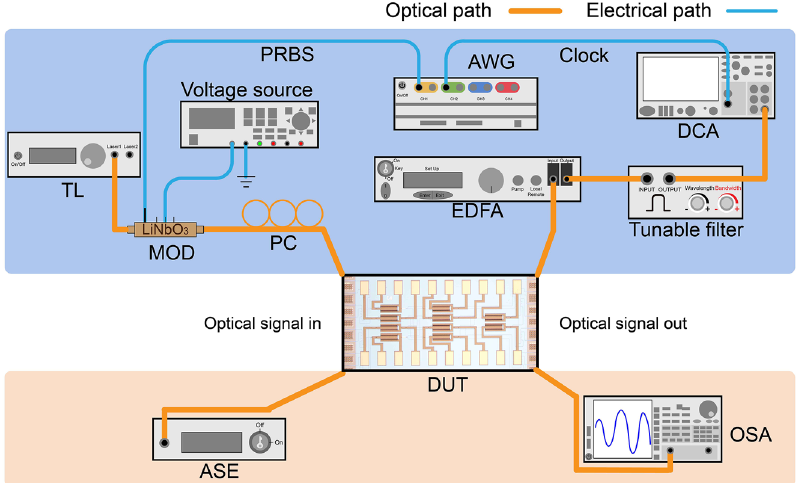
Figure 5: Experimental setup for characterizing the device (TL, tunable laser; ASE, amplified spontaneous emission; MOD, modulator; PC, polarization controller; AWG, arbitrary waveform generator; DUT, device under test; DCA, digital communication analyzer; OSA, optical spectrum analyzer). Table 1: The switch’s states and the corresponding optical links. State of the